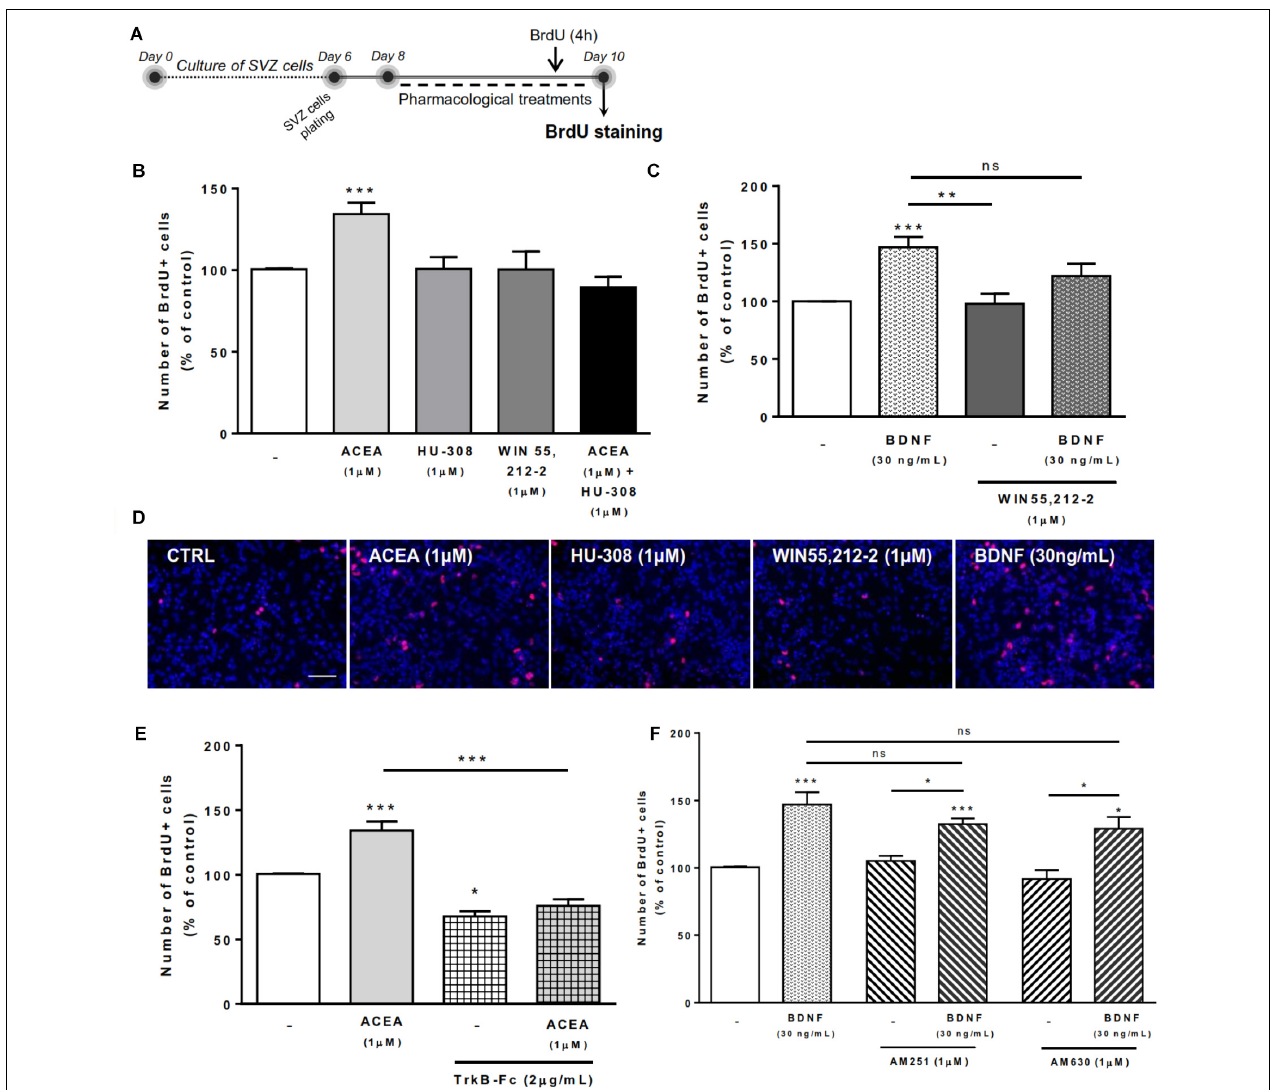
FIGURE 2 | CB1R-induced SVZ proliferation is dependent on endogenous BDNF. SVZ proliferation was increased by CB1R activation and treatment with BDNF. BDNF was required for CB1R-mediated effect to occur. Conversely, BDNF-mediated effect was independent of CB1R or CB2R modulation. (A) Schematic representation of the experimental protocol. Day 0 represents the day of cultures; at Day 6 SVZ neurospheres were plated for 48 h and at Day 8 cells were exposed to pharmacological treatments for further 48 h (Day 10). (B,C,E,F) Bar graphs depict the number of BrdU-positive cells. Values were normalized to the control mean for each experiment and are represented as mean ± SEM. Control was set to 100%. n = 3-19. ∗ p < 0.05 and ∗∗∗ p < 0.001 using Dunnett’s multiple comparison test. ns, non-significant. (D) Representative fluorescent digital images of cells immunopositive for BrdU (in red) and Hoechst 33342 staining (blue nuclei). Scale bar = 50 µ